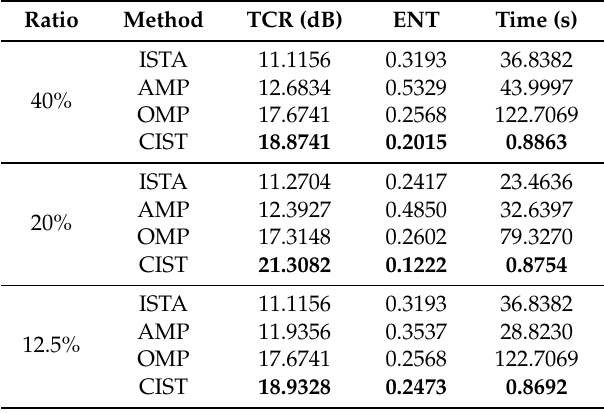
Figure 9. ISAR imaging results of data II of different methods at ratio 40%, 20% and 12.5%, respectively. Table 4. Evaluation for Measured Experiments of data